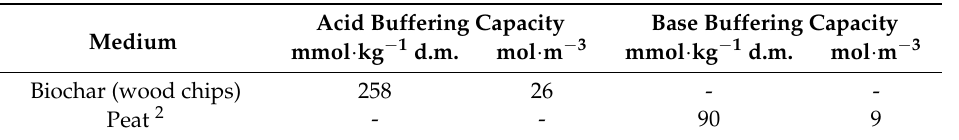
Table 3. Acid buffering capacity of biochar and base buffering capacity of peat, determined by titration 1 , expressed per unit weight of dry matter (d.m.) and per unit of volume.